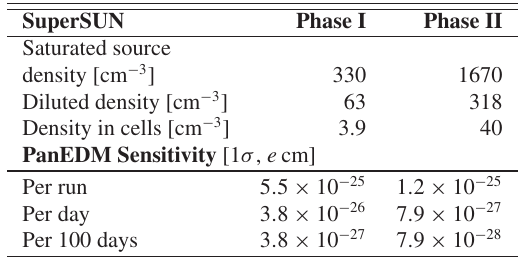
Table 1. Estimated statistical sensitivity, assuming continuous operation with a 400s repetition period (250s free precession, with 150s preparation/detection). One reactor cycle ≈ 50